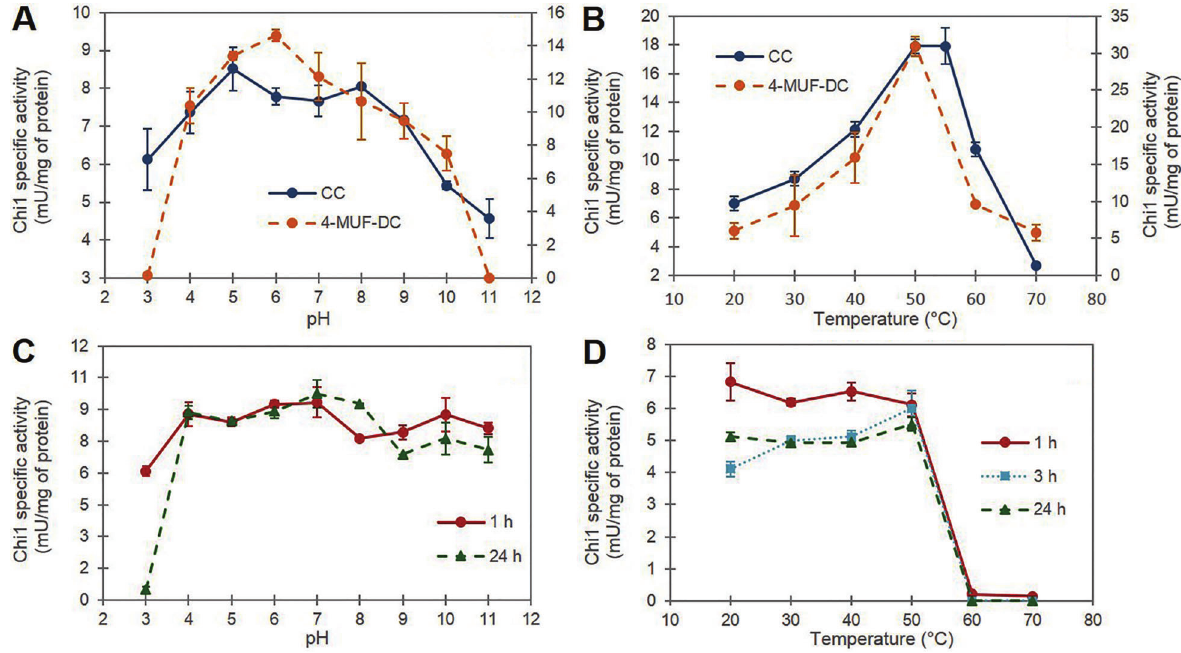
Figure 4. Effect of pH and temperature on MetaChi18A activity and stability. Chitinolytic activity was determined using 0.2 mg/mL of 4-MUF derivatives ( A and B orange slashed line, Y-axis on the right) and 10 mg/mL of colloidal chitin ( A and B dark blue line, Y-axis on the left) as substrate. Enzyme concentration was 0.40 and 100 ng/ m L, respectively. A , Effect of pH on the activity for 30 min at 37°C; B , effect of temperature on the activity for 30 min at pH 5; C , stability of MetaChi18A incubated at indicated pH for 1 or 24 h without substrate; D , stability of MetaChi18A incubated at the indicated temperature for 1, 3, or 24 h without substrate. The remaining activities were measured for 30 min at 37°C and pH 5 using 10 mg/mL of colloidal chitin. The reactions were performed in 25 mM buffers: pH 3 sodium citrate; pH 4 and 5 sodium acetate; pH 6 and 7 sodium phosphate; pH 8 and 9 Tris-HCl; pH 10 and 11 sodium carbonate. Error bars represent standard deviation. One unit of chitinase activity (U) was de fi ned as the release of 1 m mol of reducing sugar or 4-MUF per